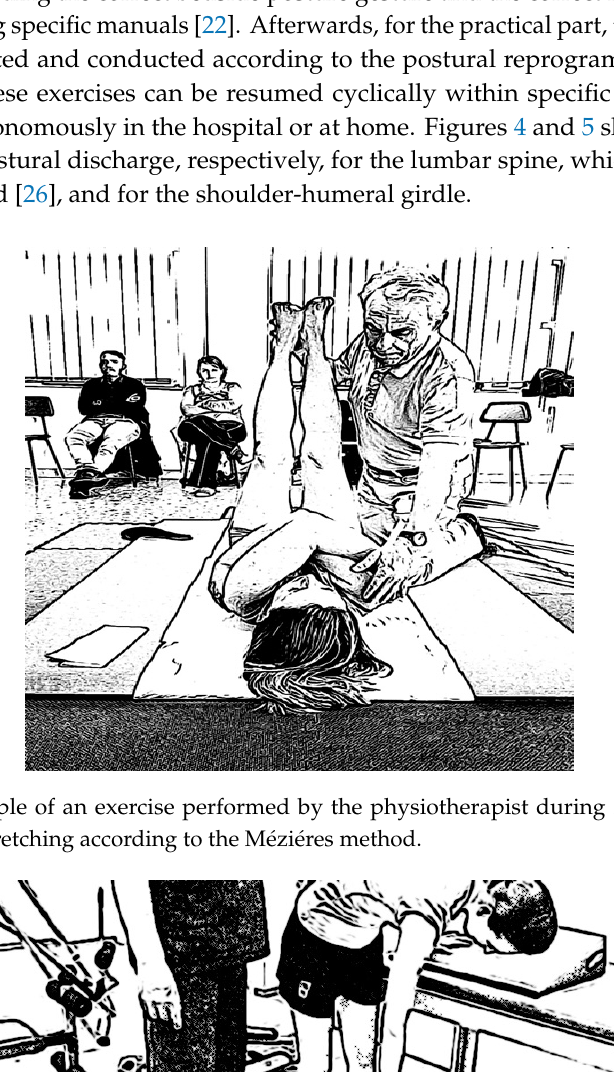
Figure 3. Answers provided by healthcare workers (HCWs) to the questionnaire. A–H each box refers to a task identified by the HCWs as overloading. The abscissa axis shows the reference number of the HCW. The ordinate axis shows the value of the Borg scale (Borg CR-10) attributed by each worker to the task.